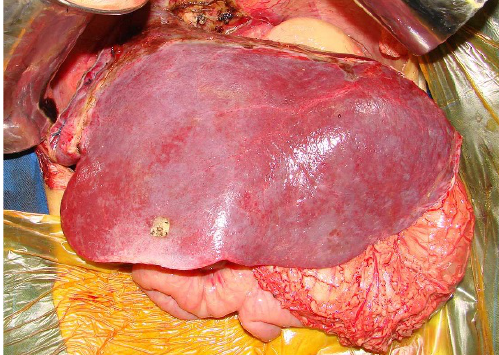
Figure 3 - Final view of the liver graft after implantation (living donor transplantation, left